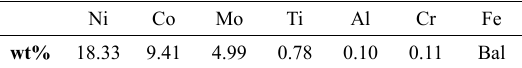
Table 1. Chemical composition of Maraging-300 steel.